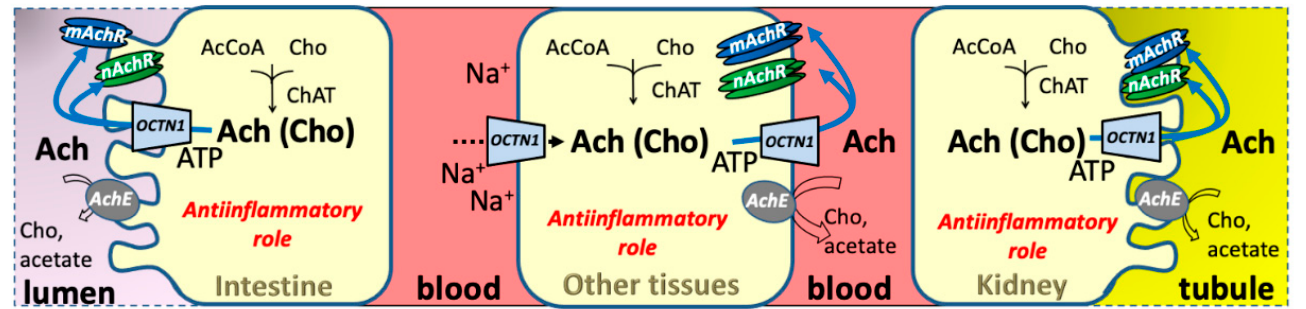
Figure 4. Metabolism and cellular role of the OCTN1 hypothesized substrate Acetylcholine, Ach (Choline, Cho). Epithelial polarized and other tissues are depicted as brushed or normal shapes. Intestine on the left, kidney on the right; other tissues in the middle. Intestine and tubular lumens are depicted in pink and yellow, respectively. Blood is depicted in red. Continuous arrows describe the OCTN1 transport of Acetylcholine (Choline); dotted arrows refer to a very low transport rate. Simplified human metabolic pathways are depicted: acetylcholine synthesis, involving the enzyme choline acetyltransferase (ChAT), and acetylcholine catabolism involving the enzyme acetylcholinesterase (AchE; gray circle); receptor interactions are reported (nAchR and mAchR, green and blue barrel shapes, respectively). Transport regulation by sodium and adenosine triphosphate is shown.